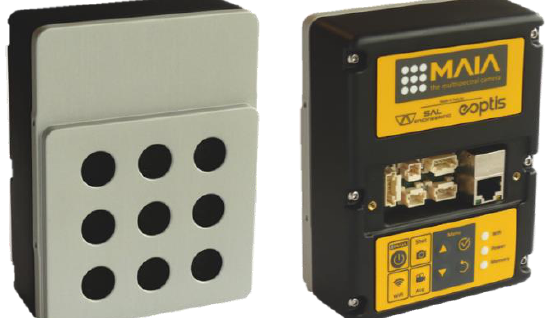
Figure 1. The MAIA multispectral